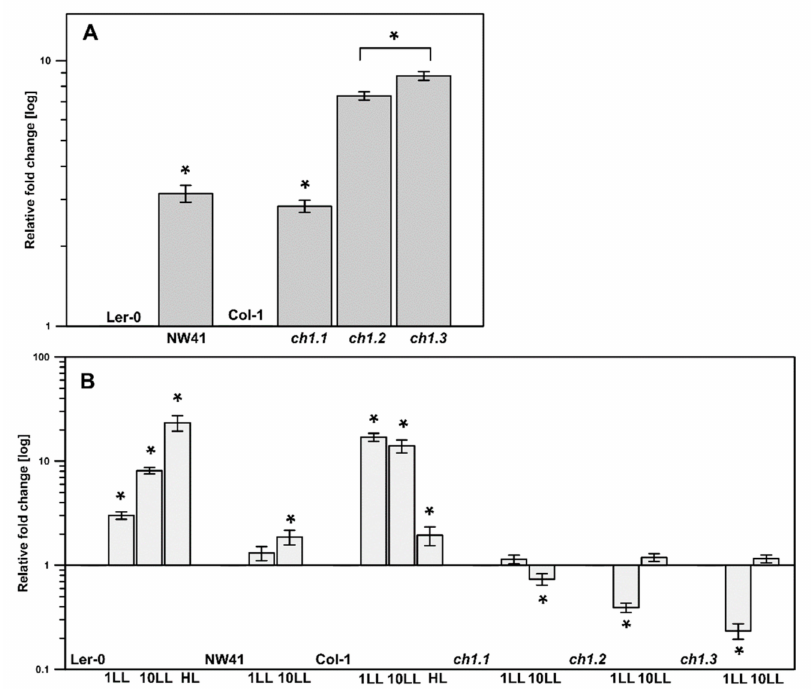
Figure 5. Relative mRNA levels of the CAO gene expression: ( A )—in reference to the corresponding ecotype in NL (normal light) conditions, ( B )—in reference to NL conditions for each plant; NL— normal light, LL—low-light conditions (1, 10—after 1st and 10th day of treatment), HL—high- light conditions. The data are mean values ± SD from 3 independent experiments; results marked with an asterisk differ significantly at p = 0.05 from the corresponding ecotype/plant in NL